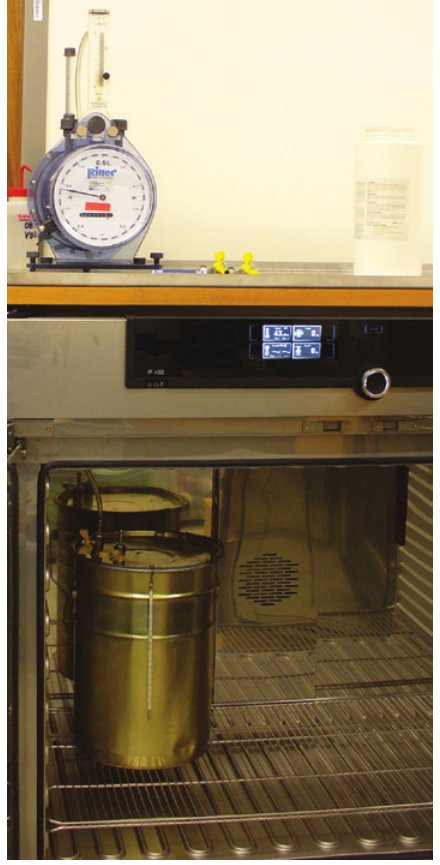
Figure 2: Stationary barrel control bioreactor in the